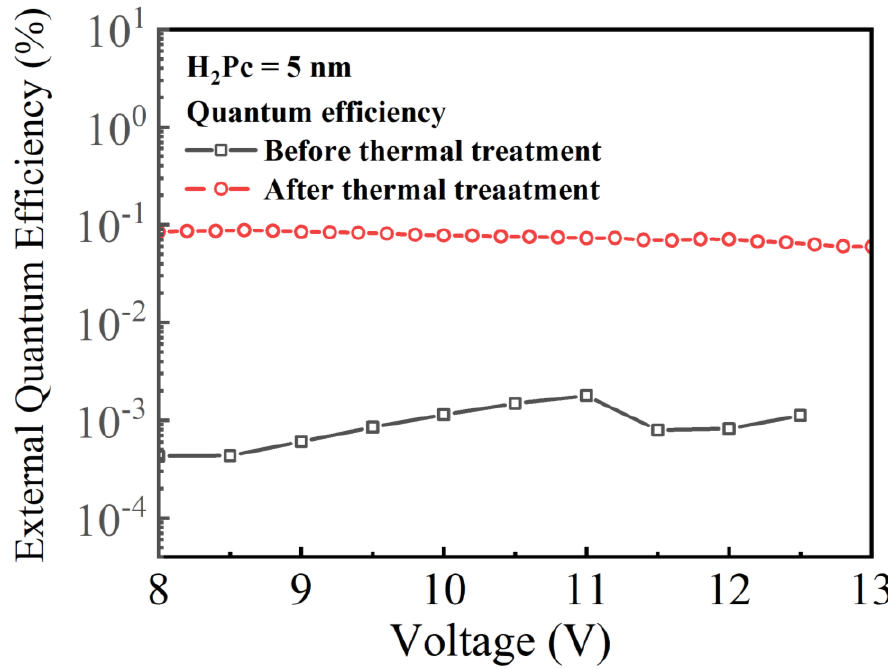
Figure 12. External quantum efficiency ( EQE )-voltage ( V ) characteristics of the CTOLED before and after thermal efficiency.